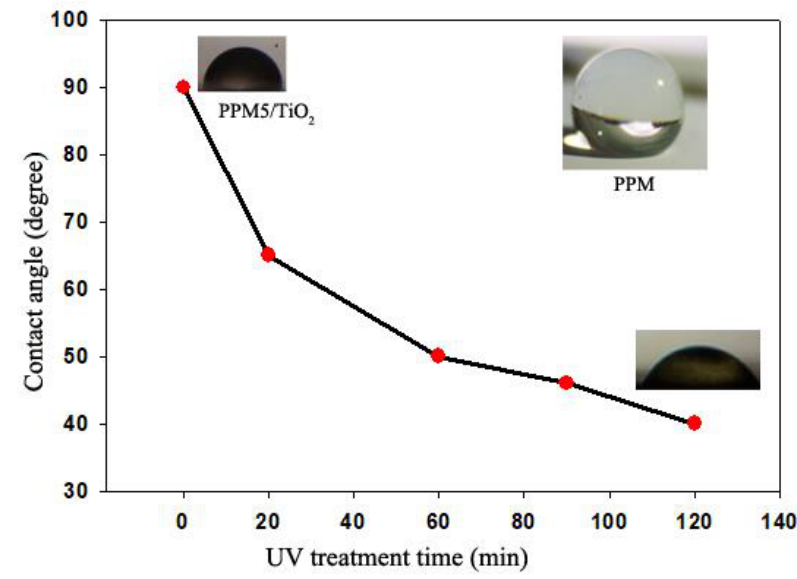
Figure 7. WCA (water contact angles) as a function of UV treatment time.